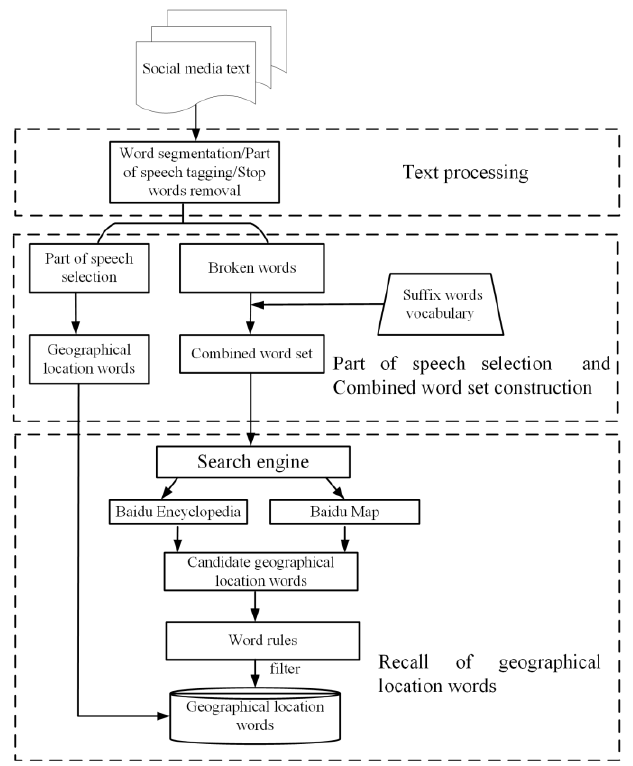
Figure 3. The process of extracting locational words in social media text.